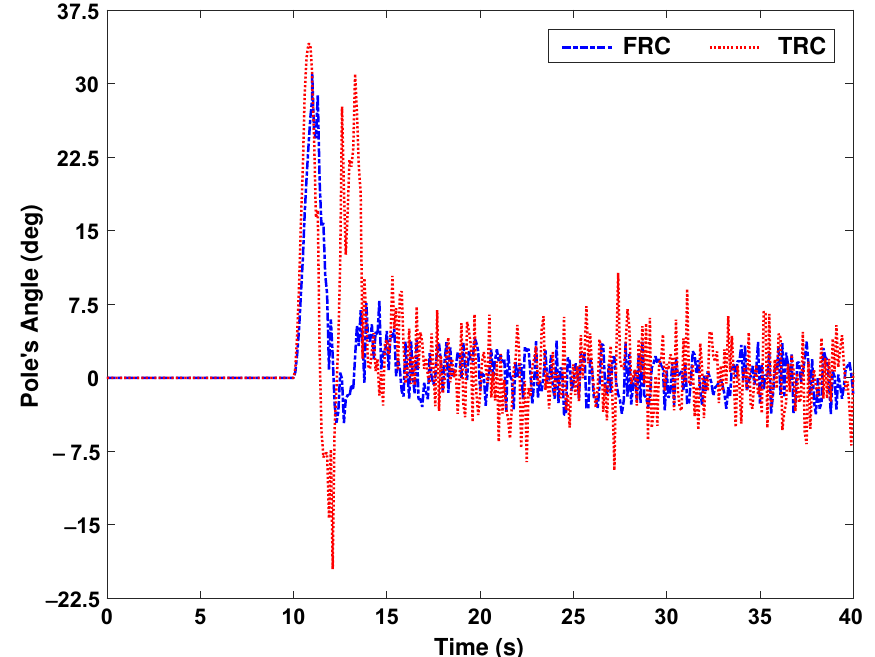
Figure 15. Angle control despite parametric